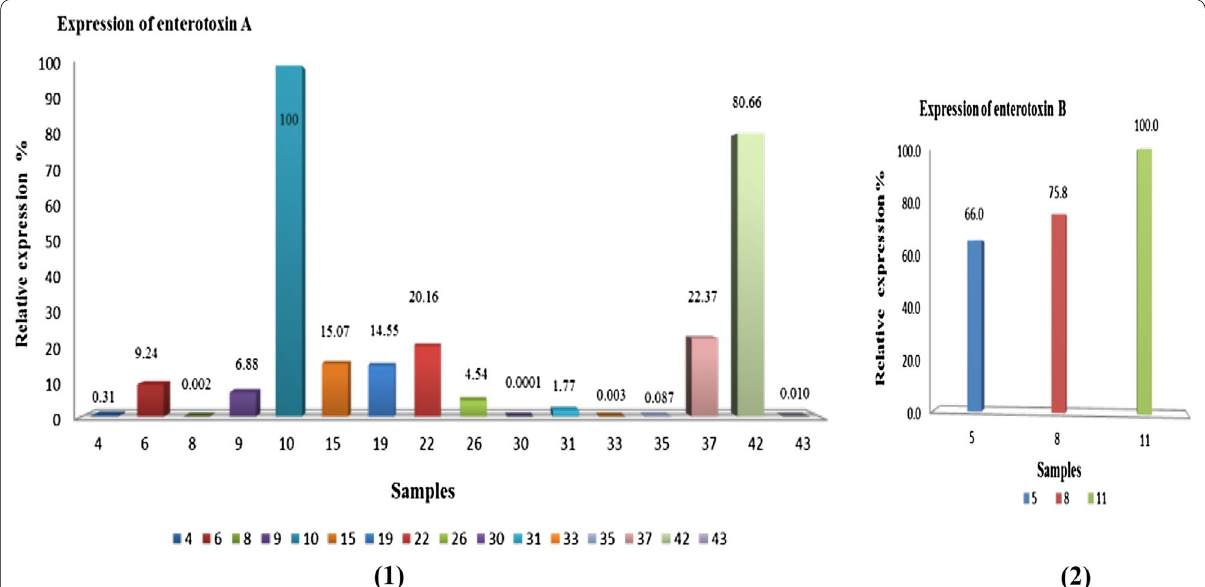
Fig. 3 Histogram for estimation the quantitative expression level of specific enterotoxin A gene (1) and for estimation the quantitative expression level of specific enterotoxin B gene